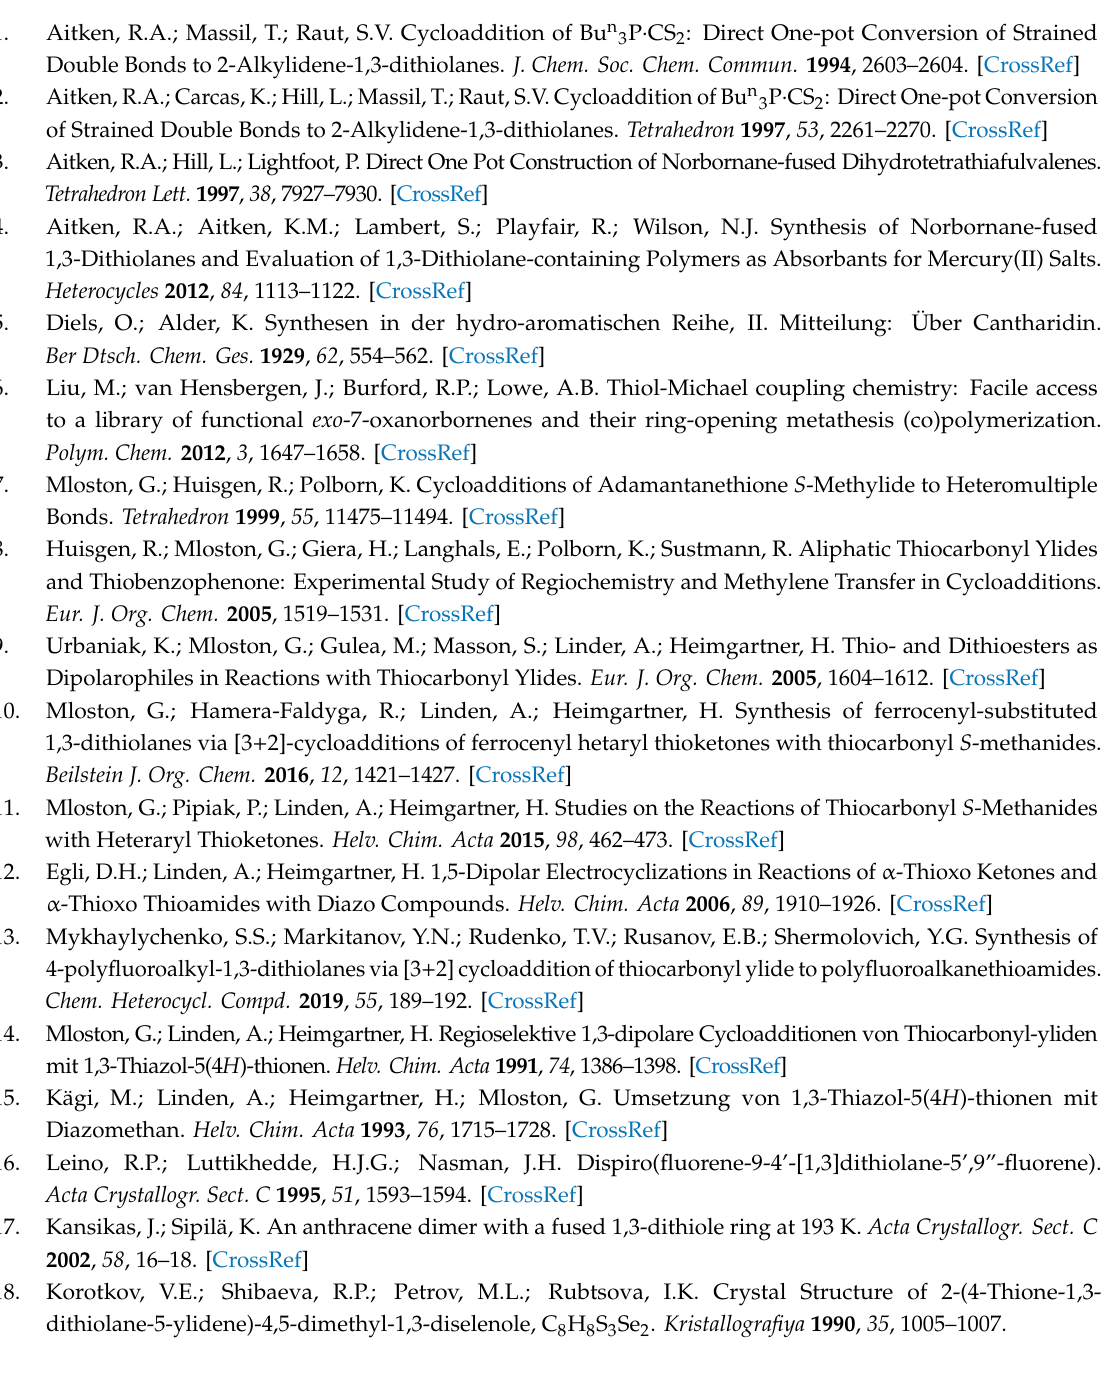
Supplementary Materials: The following is available online. Figure S1: 1 H NMR spectrum of 1 ; Figure S2: 13 C NMR spectrum of 1 ; Figure S3: HSQC 2D C–H correlation NMR spectrum of 1 ; Figure S4: IR spectrum of 1